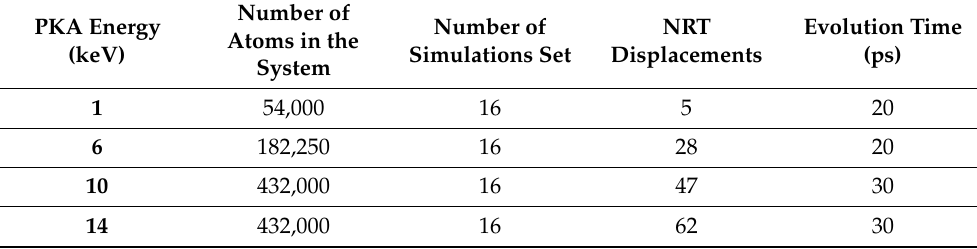
Table 2. Simulation settings for collision